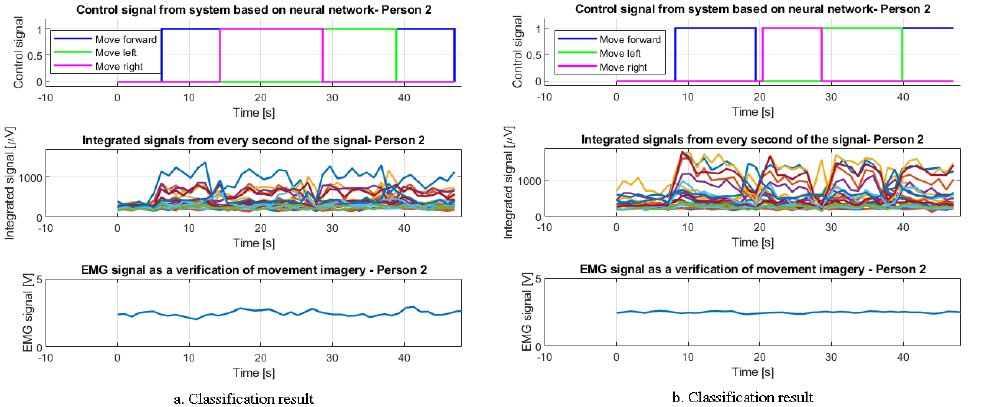
Figure 19. Observation of the signal classification and verification results—Person 2.